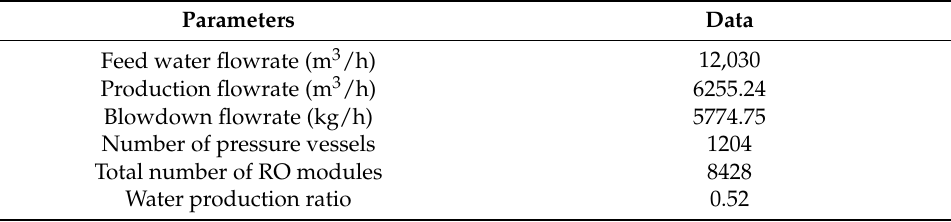
Table 1. Water production of the SWRO system.